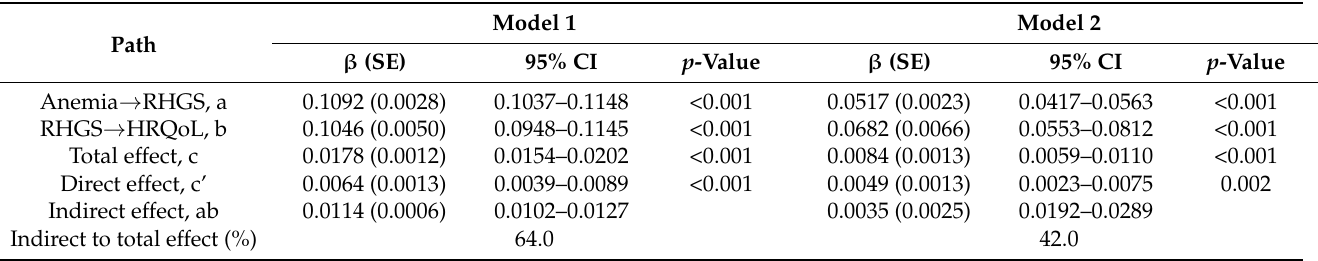
Table 4. The association between anemia and health-related quality of life in older Korean adults, mediated by relative handgrip strength.